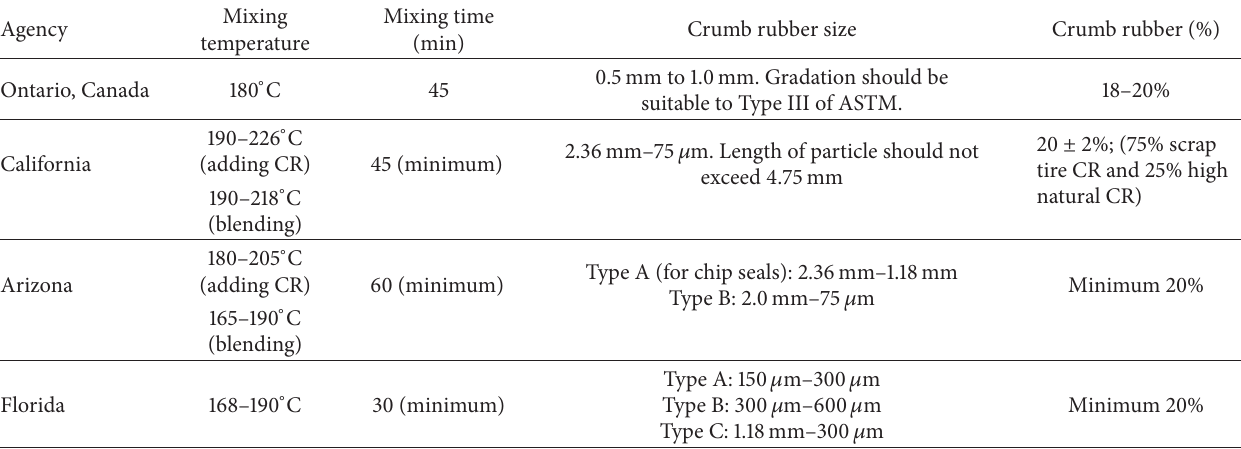
Table 2: Mixing parameters used by several Transportation Agencies (adopted from [9]).